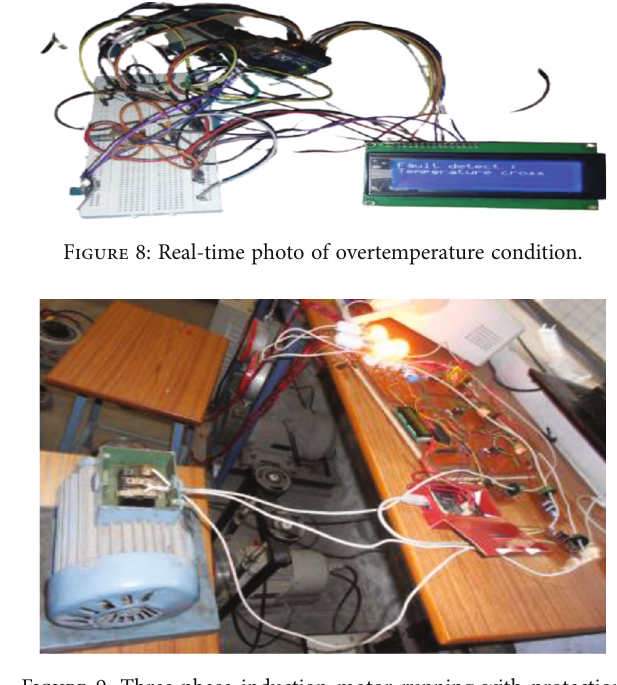
Figure 9: Three-phase induction motor running with protection